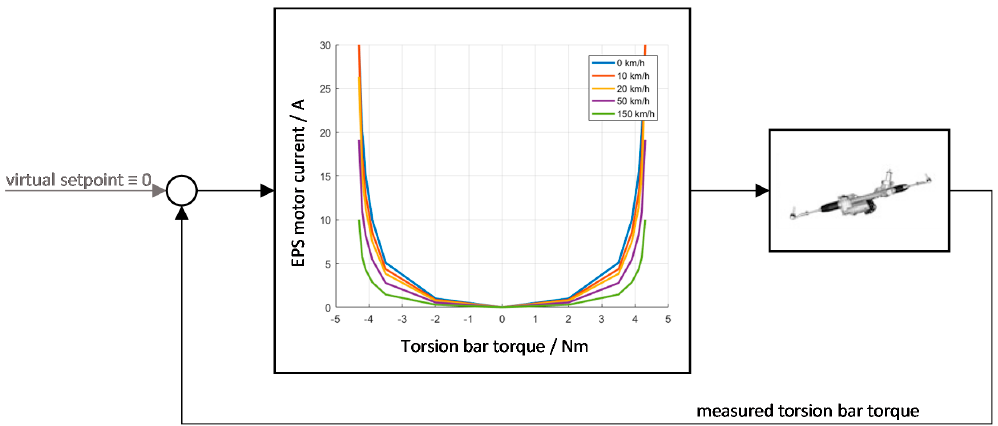
Figure 2. Control circuit with classical Electric Power Steering (EPS) control plan (based on [8]) and power assistance characteristic curves (based on [9]).